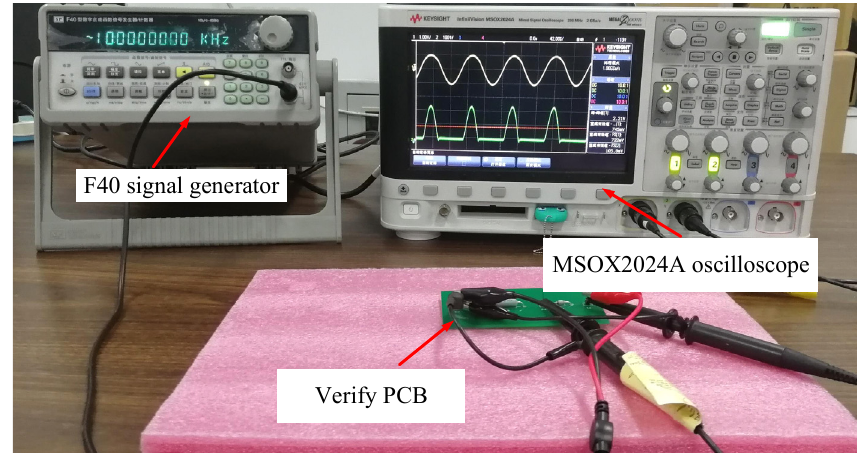
Figure 13. The reverse recovery characteristics test system for diode.